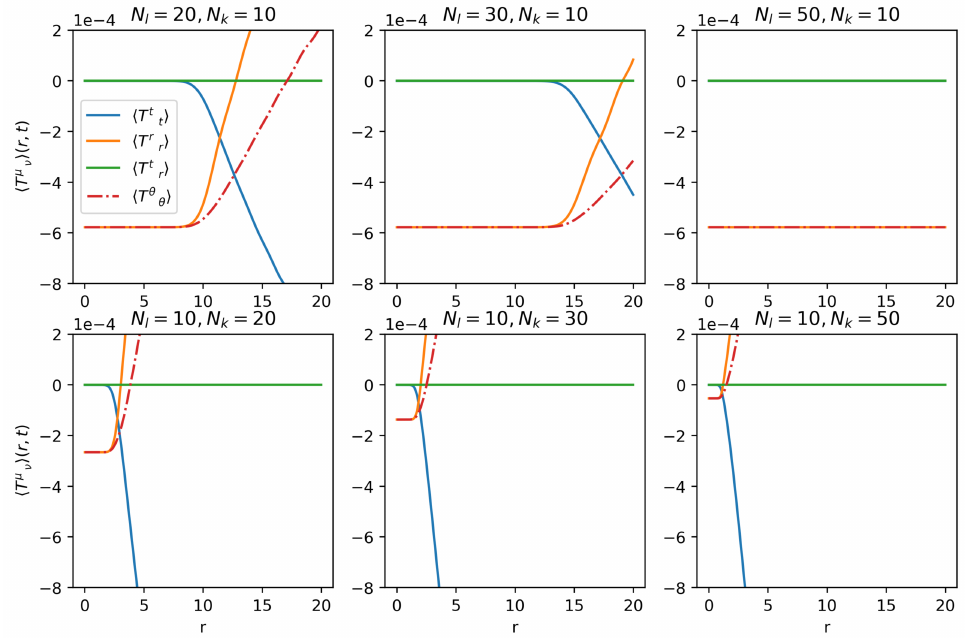
Figure 2 . Expectation values of stress-energy tensor components in the case of zero coherent state expectation value for various numbers of quantum mode functions, with different numbers of l -modes and k